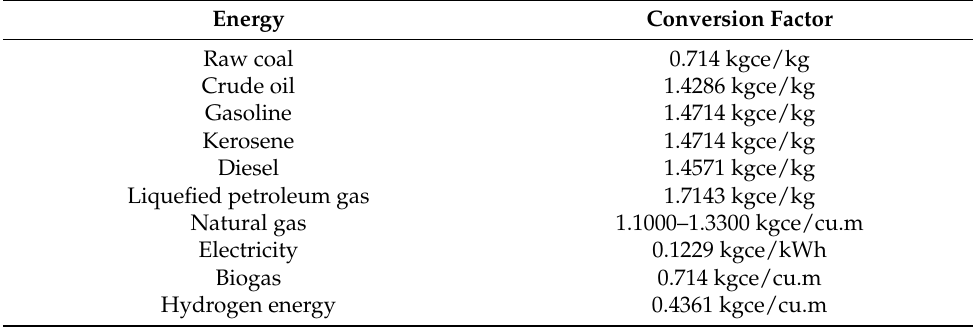
Table 4. The conversion factors from physical units to coal